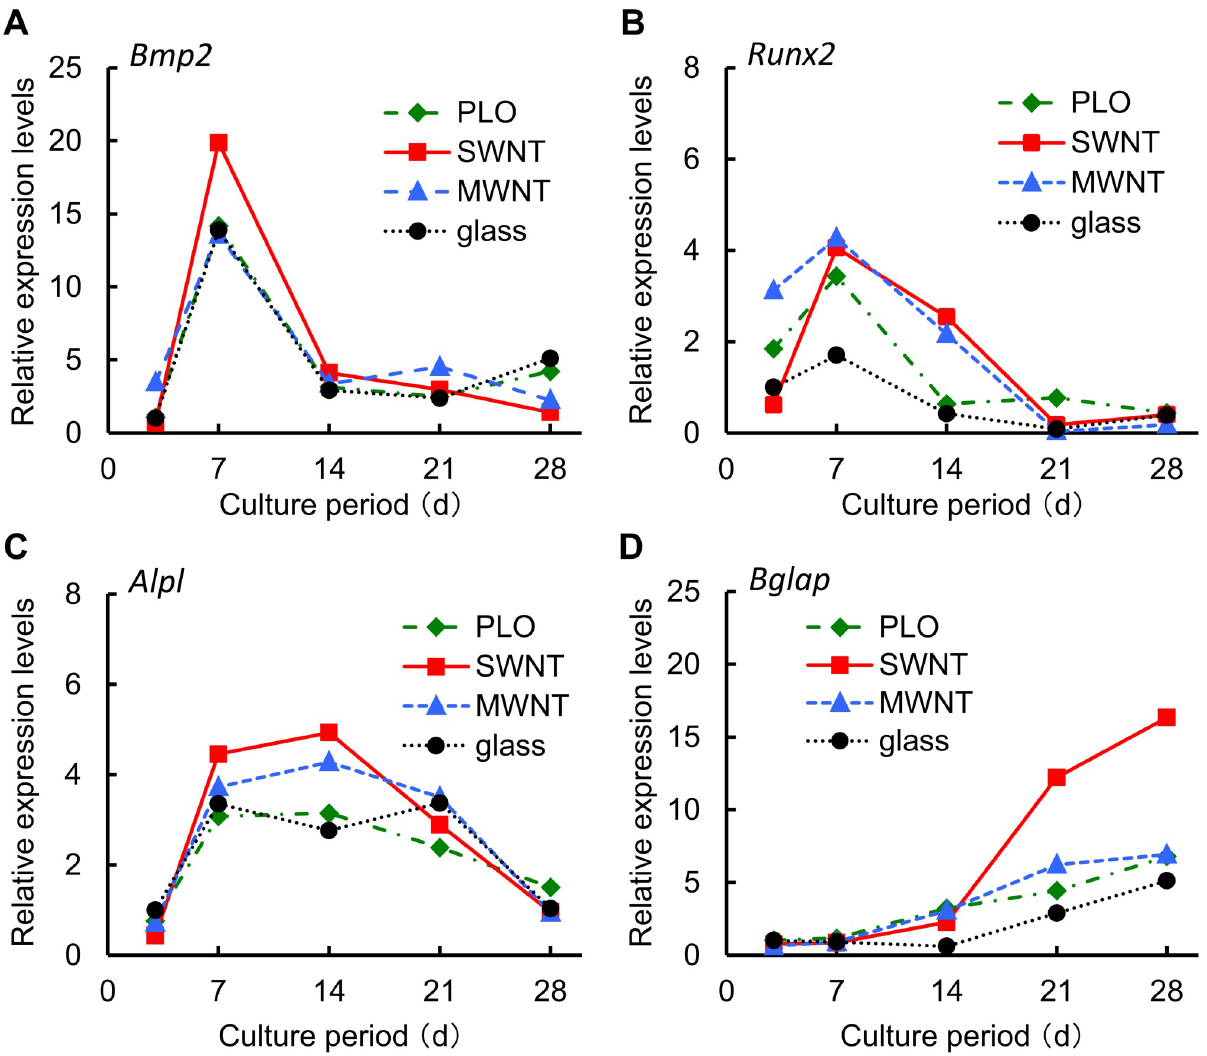
Fig 3. Expression analysis of the genes associated with osteogenic differentiation. The expression levels of (A) bone morphogenic protein 2 ( Bmp2 ), (B) runt-related transcription factor 2 ( Runx2 ), (C) alkaline phosphatase ( Alpl ), and (D) osteocalcin ( Bglap ) for MSC incubated on uncoated glass, and glass coated with SWNT, MWNT and PLO. Results are means of the duplicate experiments relative to the expression levels for MSC grown on uncoated glass at day